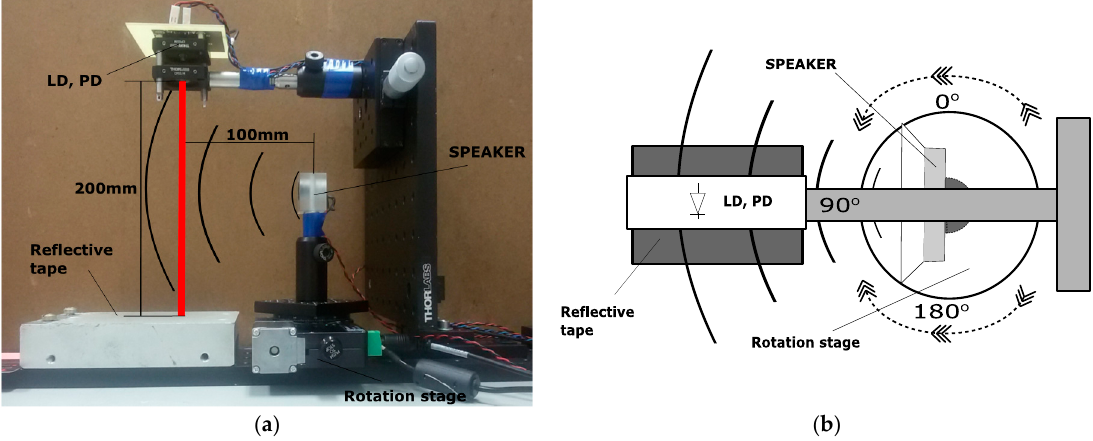
Figure 2. ( a ) Side view of the setup that includes an ultrasonic piezoelectric transmitter (MA40B8S) driven by a sinusoidal voltage at 40kHz, 10 V and the optical feedback interferometer consisting in a laser diode ML725B11F emitting at 1310 nm associated to a microspheres reflective tape; ( b ) Top view of the setup, showing the rotating stage position from 0° to +180° with clockwise and counter clockwise